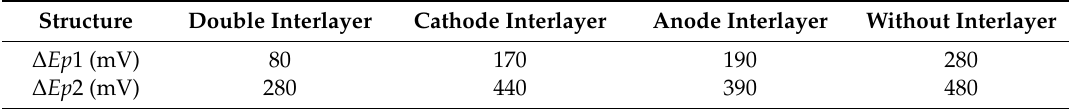
Table 3. The ∆ Ep of different structure cells.